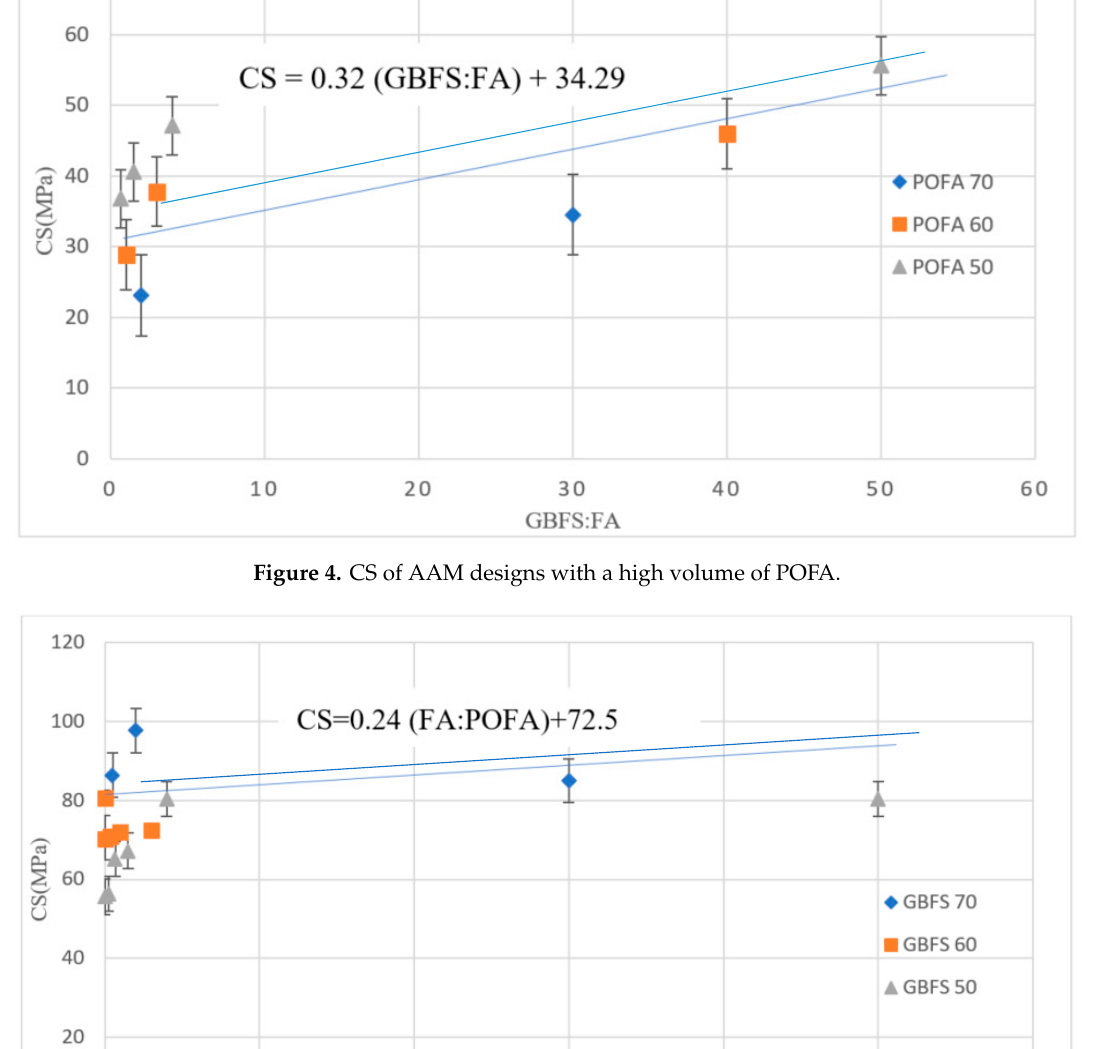
Figure 3. CS of AAM designs with a high volume of FA.